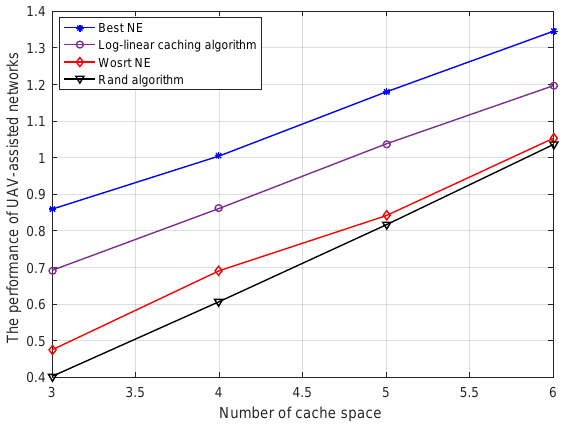
Figure 4. The performance of UAV-assisted networks versus the size of cache space of UAVs ( | f | = 6 and N = 8).